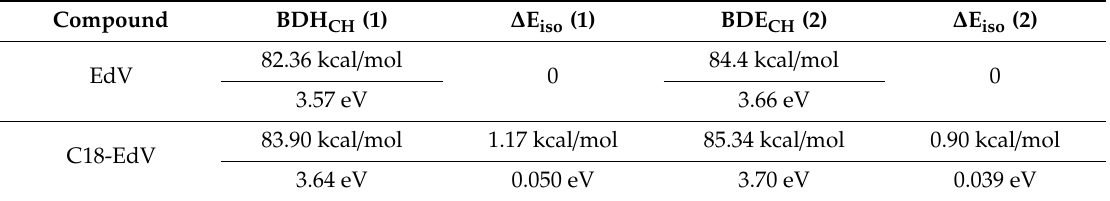
Table 1. Calculated (B3LYP / 6-311 ++ G (d, p)) bond dissociation enthalpy (BDH) for the C-H bond at position 4 in a vacuum (1) and in methanol (PCM)